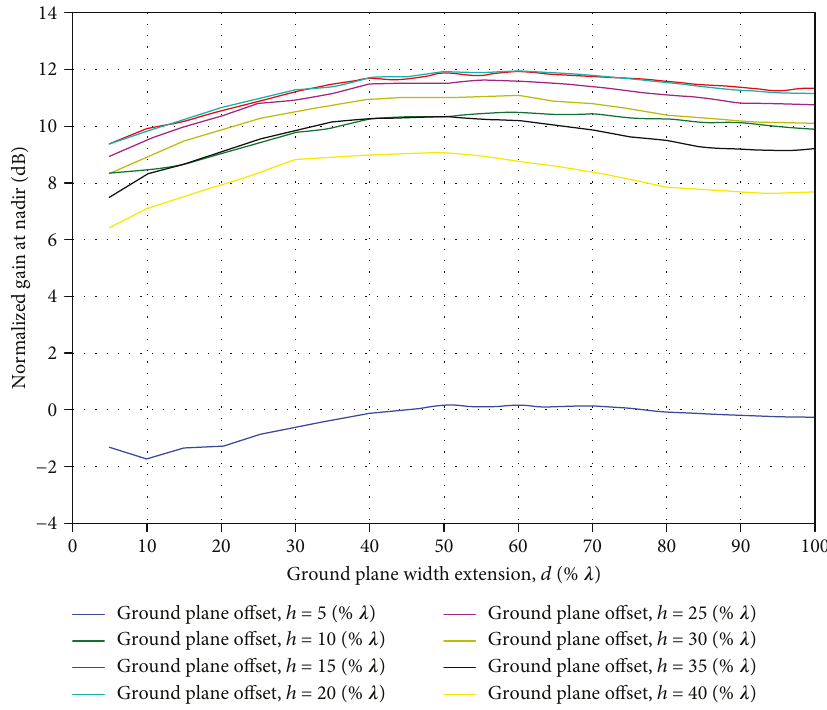
Figure 23: Comparing the ground plane width extension versus realized gain at nadir plots at di ff erent ground plane o ff